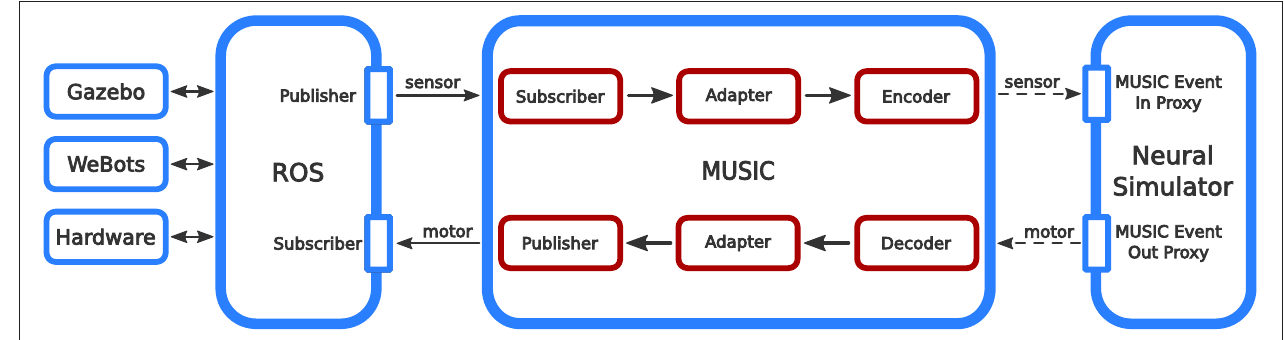
FIGURE 1 | Information flow in the ROS-MUSIC toolchain. The boxes with red outlines depict our extensions to MUSIC that facilitate the bidirectional conversion of continuous and spiking signals (solid and dashed arrows,